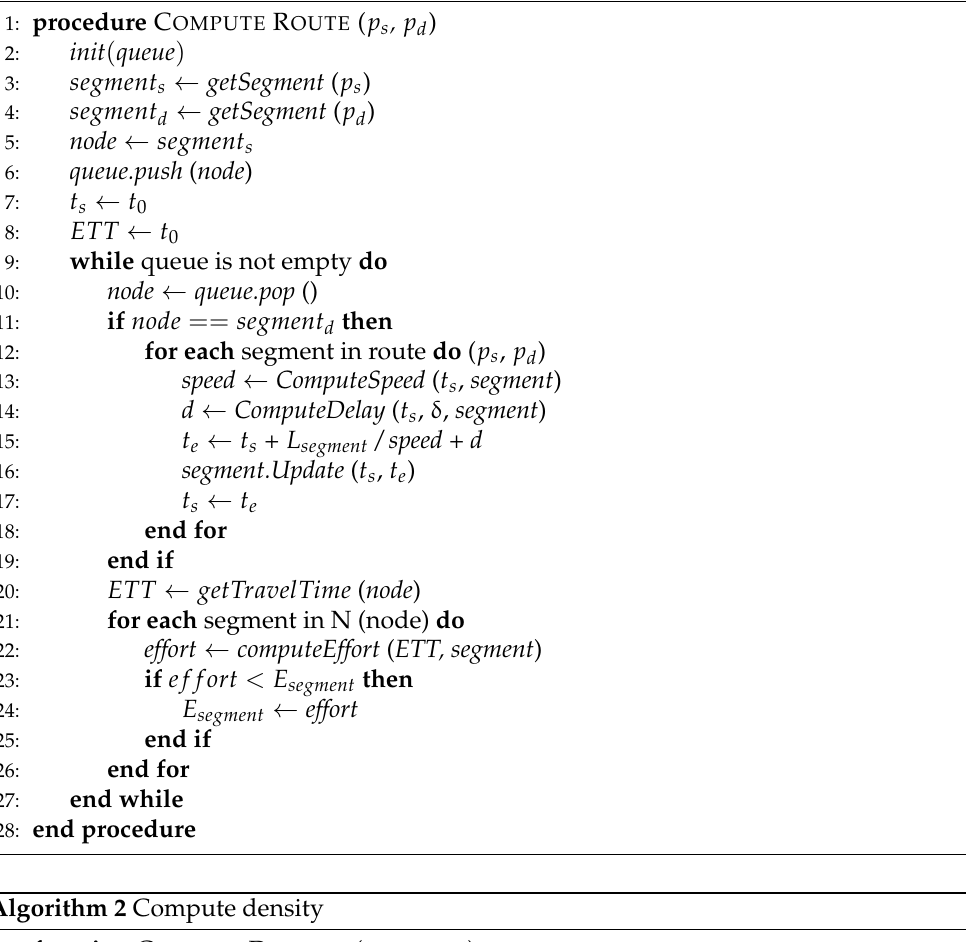
Algorithm 2 Compute density